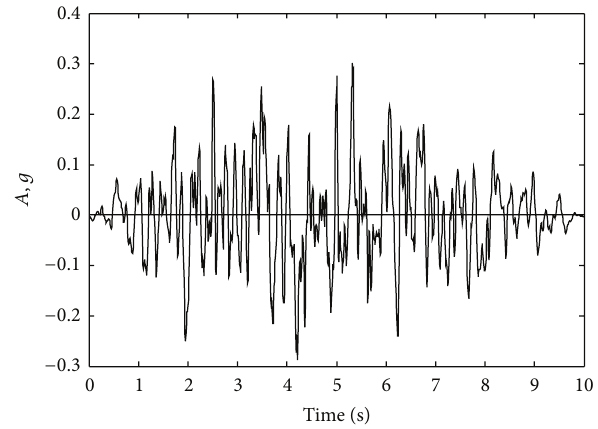
Figure 11: Time history graphs of synthetic acceleration.